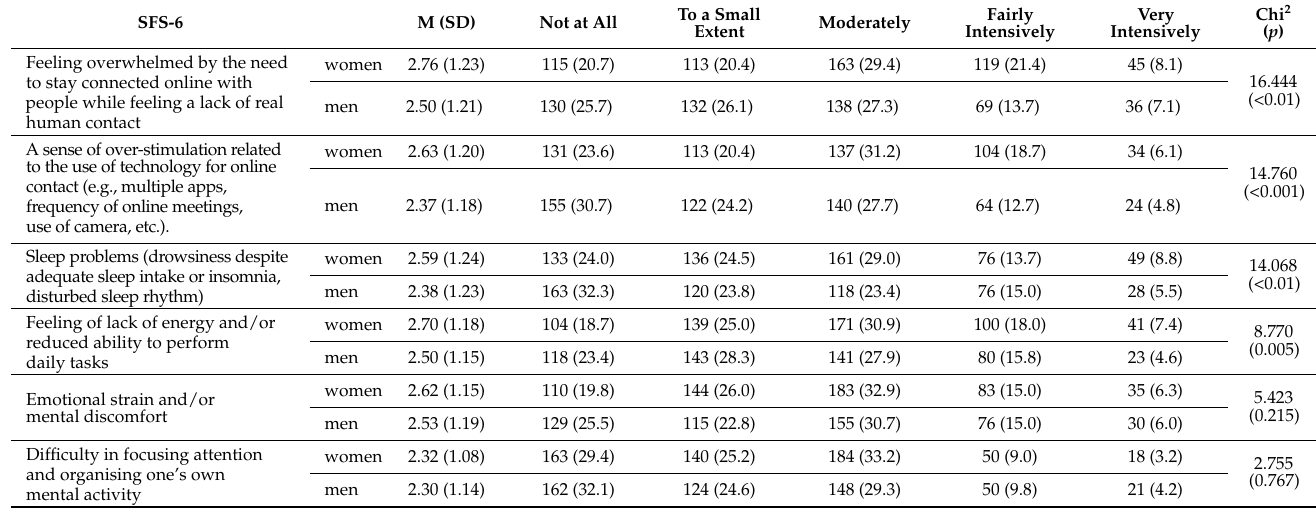
Table 3. Individual items of SFS-6 (M, SD, and frequencies) by gender (n = 1060; n